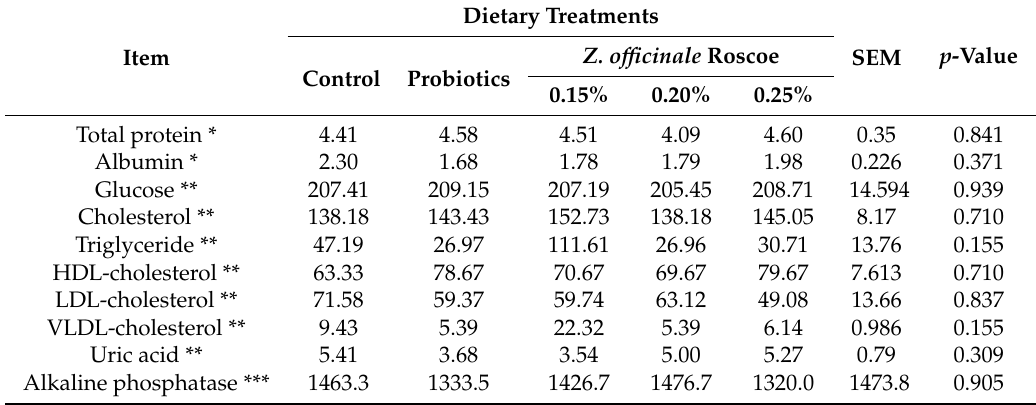
Table 4. Effect of experimental diets on serum biochemical parameters of broilers at 42 days of age.